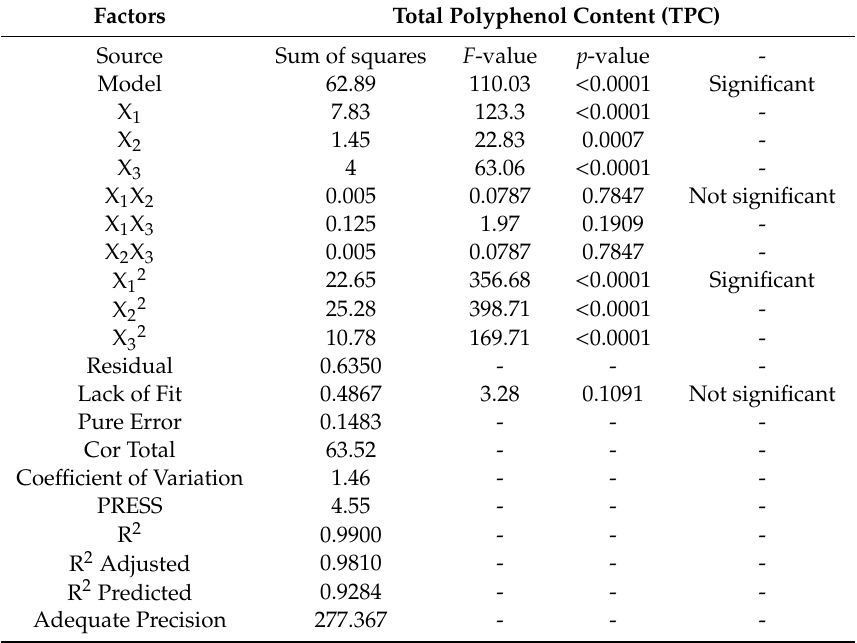
Table 4. Analysis of Variance (ANOVA) results for the quadratic model for optimization of bioactive compounds from soybean